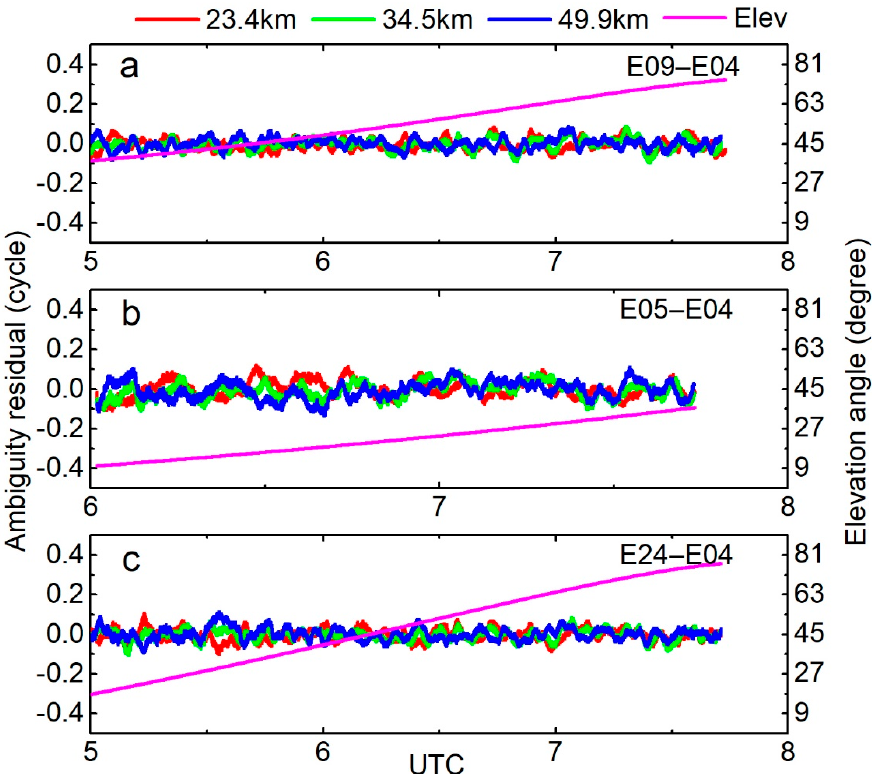
Figure 3. The optimal EWL ambiguity residual and the satellite elevation angle in the single-epoch mode ( a ): E09–E04; ( b ): E05–E04; ( c ): E24–E04).